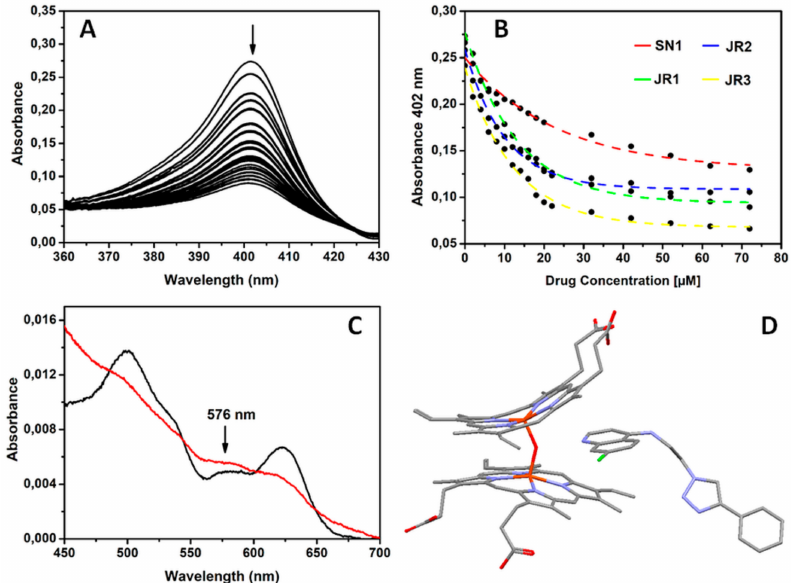
Figure 5. ( A ) Spectroscopic change observed in the Soret band of PPIX when it is titrated with drugs presented in this study. ( B ) Variation in absorbance of PPIX at 402 nm as a function of drug concentration. ( C ) Visible spectra of PPIX in 40% aqueous DMSO, pH 7.5 before (black line) and after addition of excess drug (red line). The spectrum of the latter is identical to that of the µ -oxo dimer previously reported. Note the peak maximum at 576 nm. ( D ) Density Functional Theory (DFT) optimized structure (gas-phase) of the interaction of a protonated 4-(4-ethynylphenyl)-triazole functionalized quinoline drug model with ferriprotoporphyrin IX µ -oxo